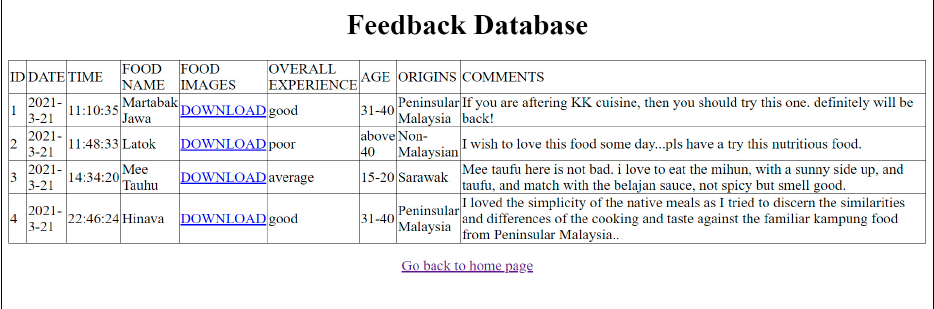
Figure 12. List of customer feedback.